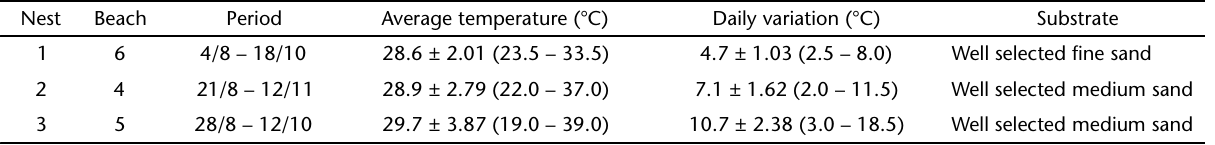
Table I. Variation in incubation temperature for P. geoffroanus on beaches along the Xingu River. The temperatures were measured every hour. Mean ± SD (range). Nest